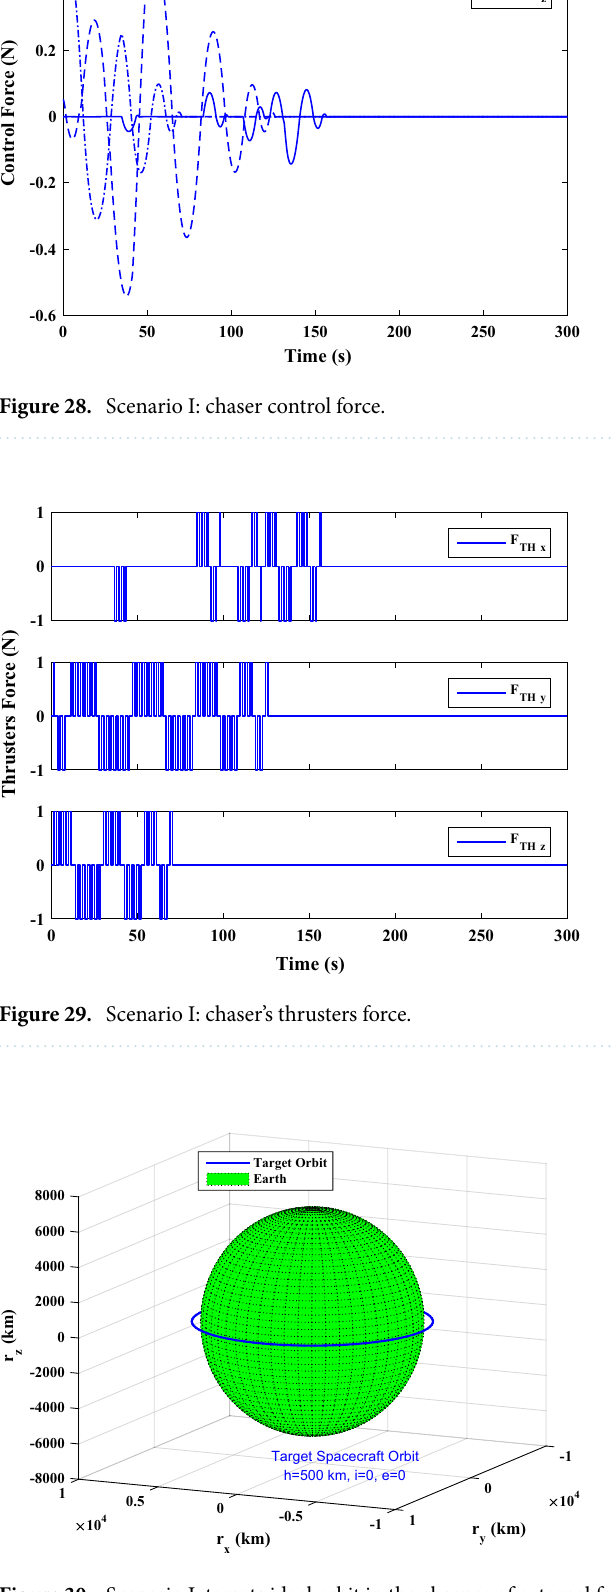
Figure 30. Scenario I: targets ideal orbit in the absence of external